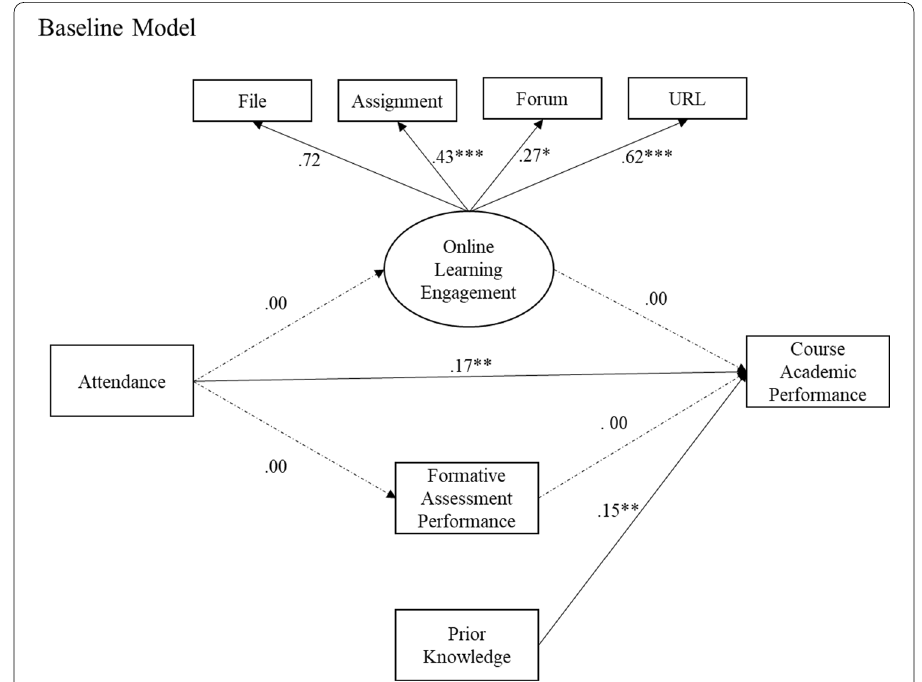
Fig. 1 SEM path diagram of baseline model